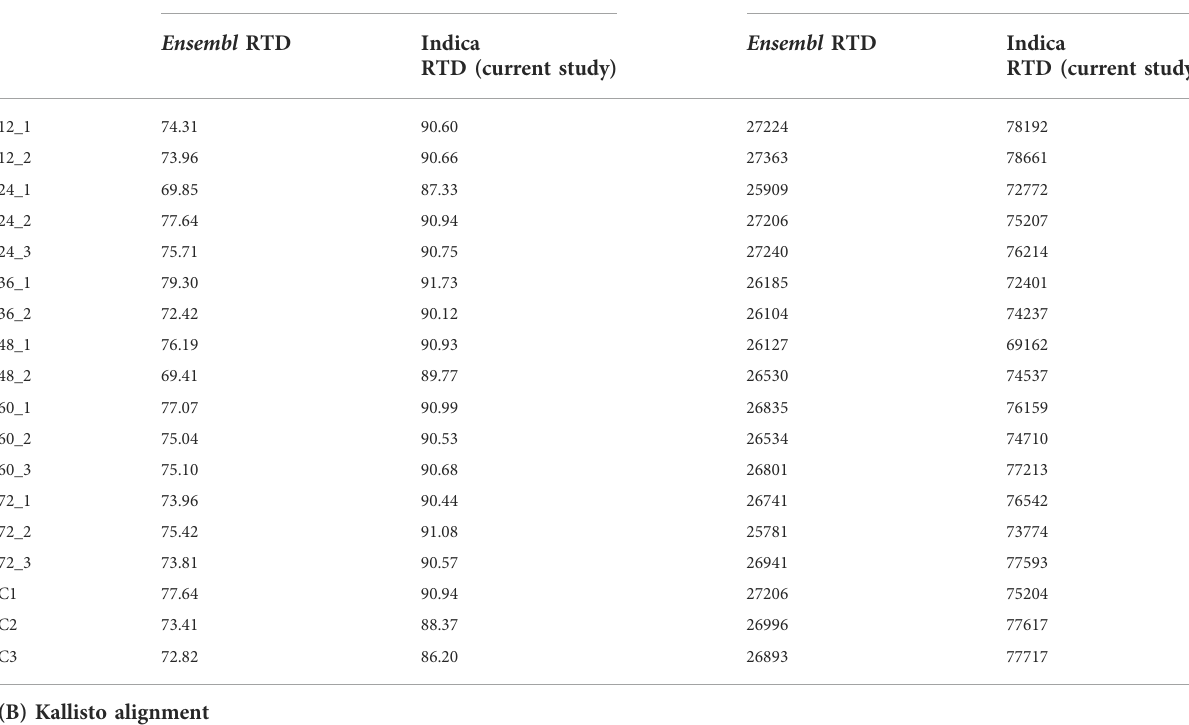
TABLE 2 Comparison of IndicaRTD and Ensembl RTD. (A) The table shows the percentages of reads aligned with the transcripts and the number of transcripts mapped by the RNA-seq reads by the Salmon mapping tool for both Ensembl and IndicaRTD annotation. (B) The table shows the percentages of reads aligned to the transcripts and the number of transcripts mapped by the RNA-seq reads by the Kallisto mapping tool for both Ensembl and IndicaRTD